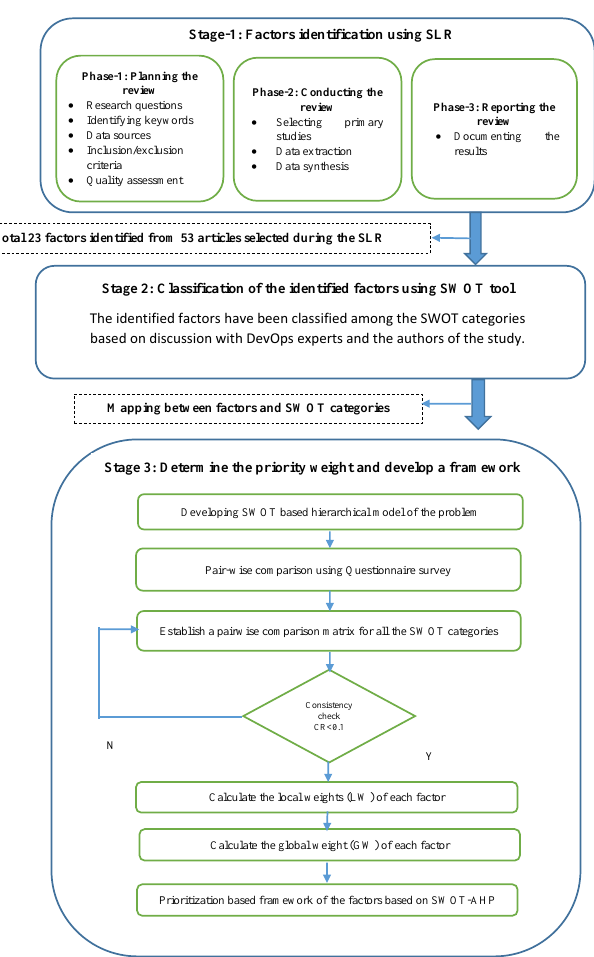
Figure 1. Proposed research